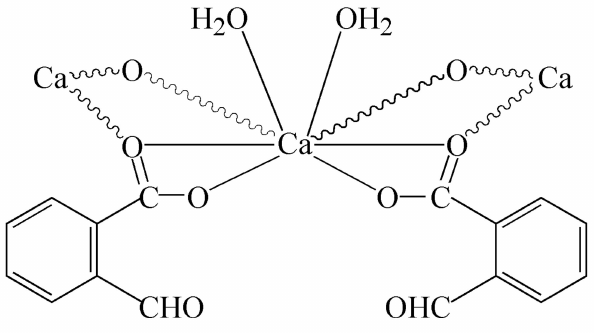
Scheme 1. The chemical diagram of the Ca(II) coordination polymer.